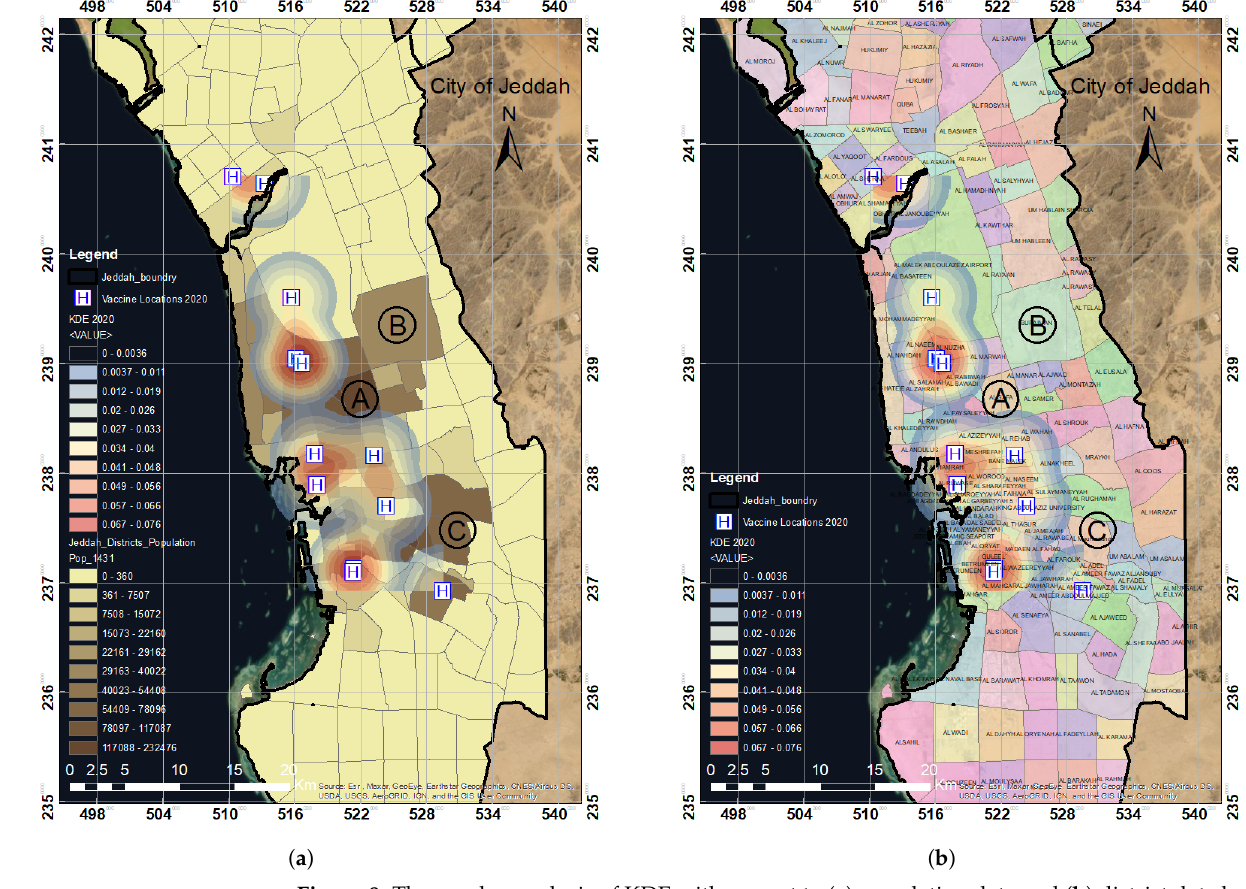
Figure 8. The overlay analysis of KDE with respect to ( a ) population data and ( b ) district data based on the spatial distribution of the COVID-19 vaccination centers established in 2020 in the city of Jeddah. The A, B, and C zones highlight the highly populated regions. ( a ) KDE analysis map in relation to population data. ( b ) KDE analysis map in relation to district